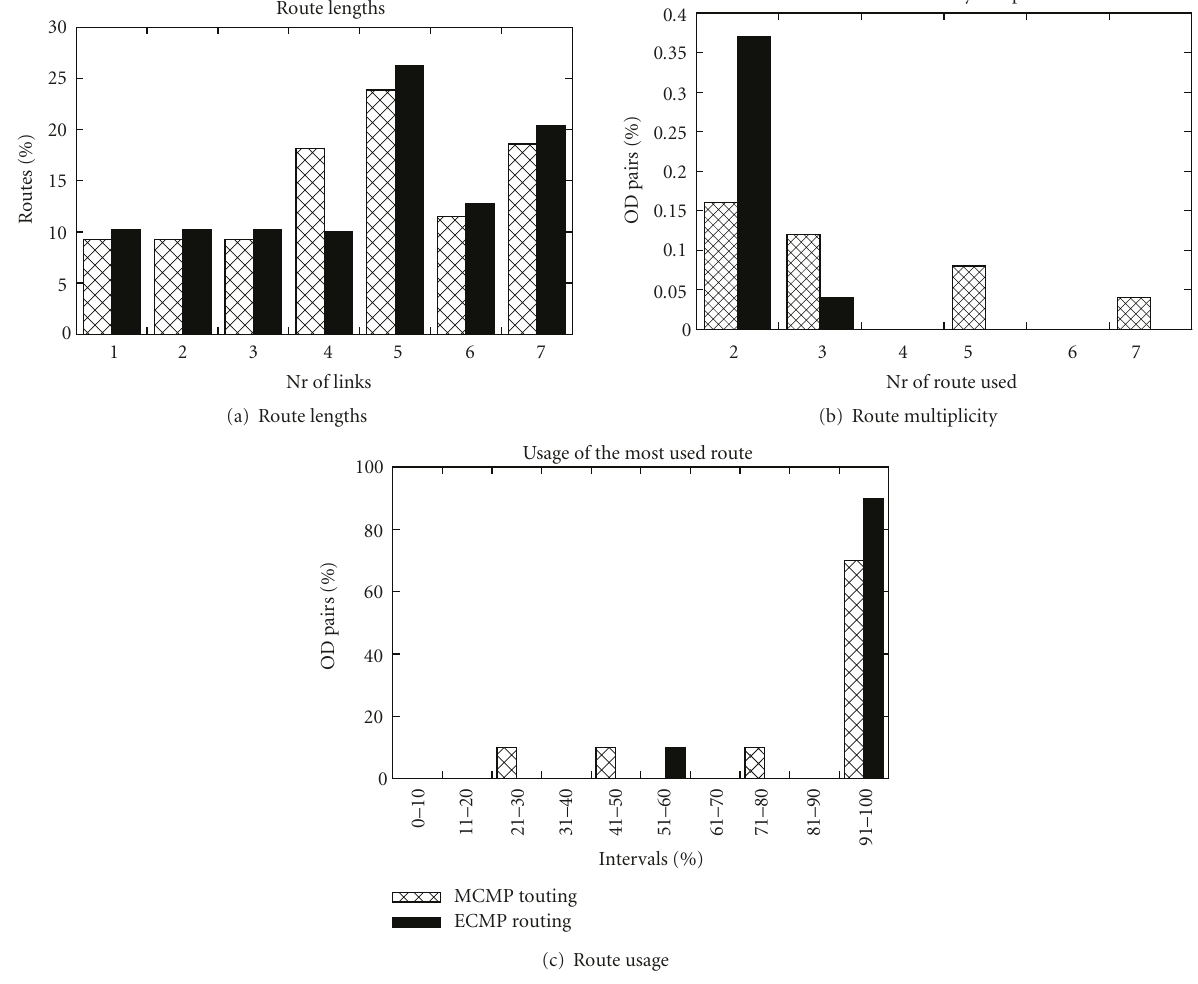
Figure 5: Quality of path: path length, multiplicity, and usage.